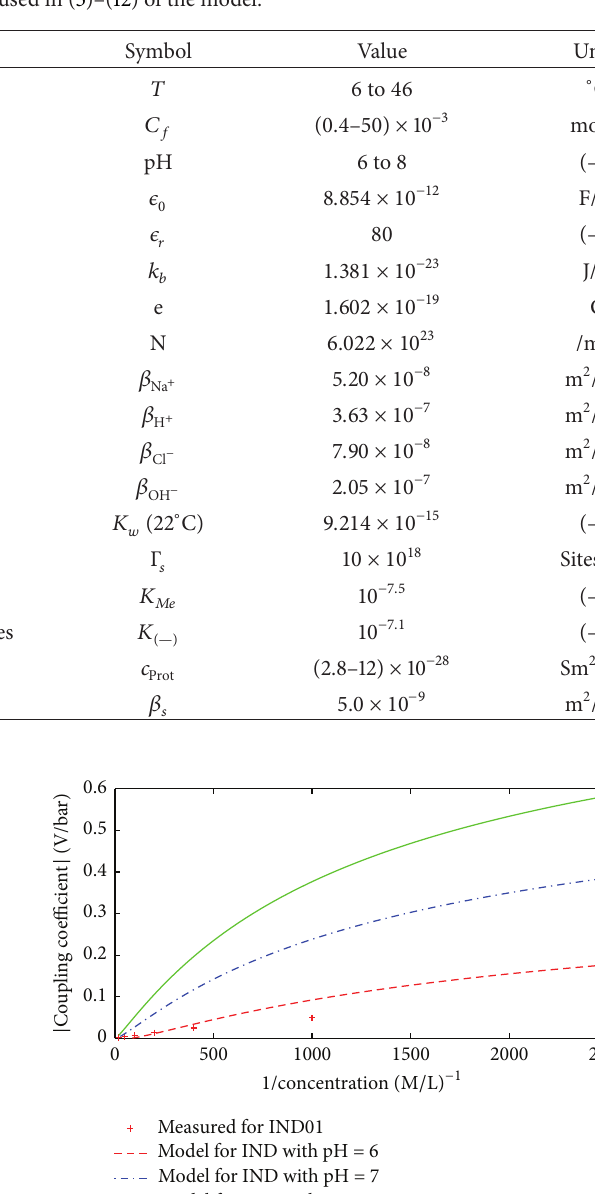
Table 3: The parameters used in (5)–(12) of the model.